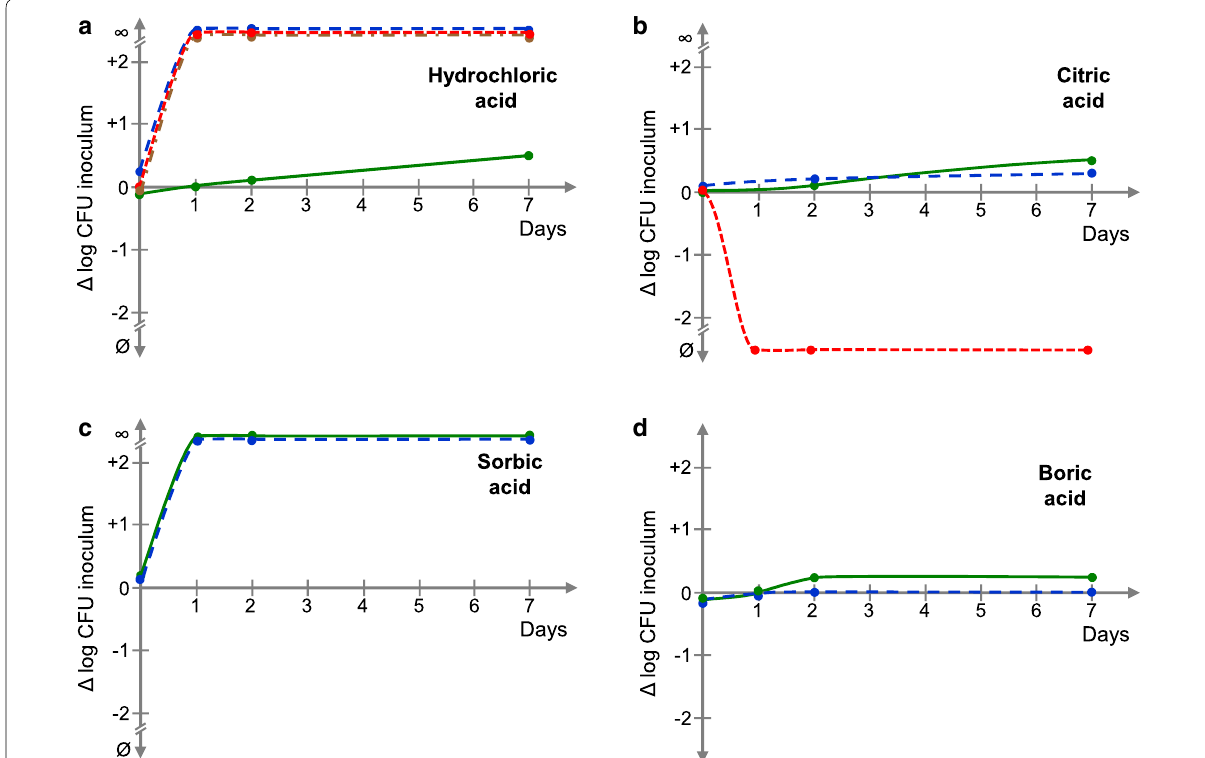
Fig. 2 Comparison of the bacteriostatic activities of media produced in the presence of different acids. The evolution of the contamination was measured over 7 days and was expressed as the logarithmic variation of the initial inoculum (Δlog CFU: colony‑forming unit). a Hydrochloric acid pH 5.39 green lines, pH 5.45 blue dotted lines, pH 5.63 red dotted lines, and pH = = = pH 4.81 blue dotted lines, and pH 4.94 red dotted lines. c Sorbic acid 0.05% green lines and 0.1%. d Boric acid 0.84% (pH = = (pH 6.00 blue dotted lines). All experiments were performed in triplicate and completed with tests at higher and lower concentrations (not =